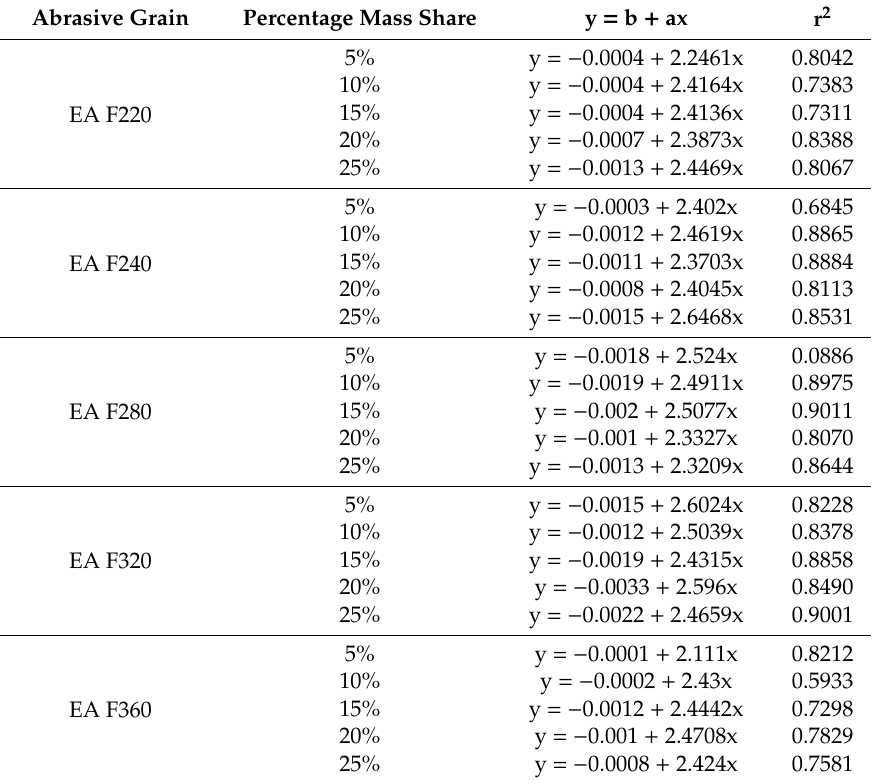
Figure 2. Exemplary graphs of the loss of weight discrepancy from the initial state, with regard to the weight loss between the cycles for epoxy resin with 5% addition of alundum with the following grains. Table 2. Regression functions of the loss of weight discrepancy from the initial state, with regard to the loss of weight between the cycles for epoxy resin with various mass shares and grains.